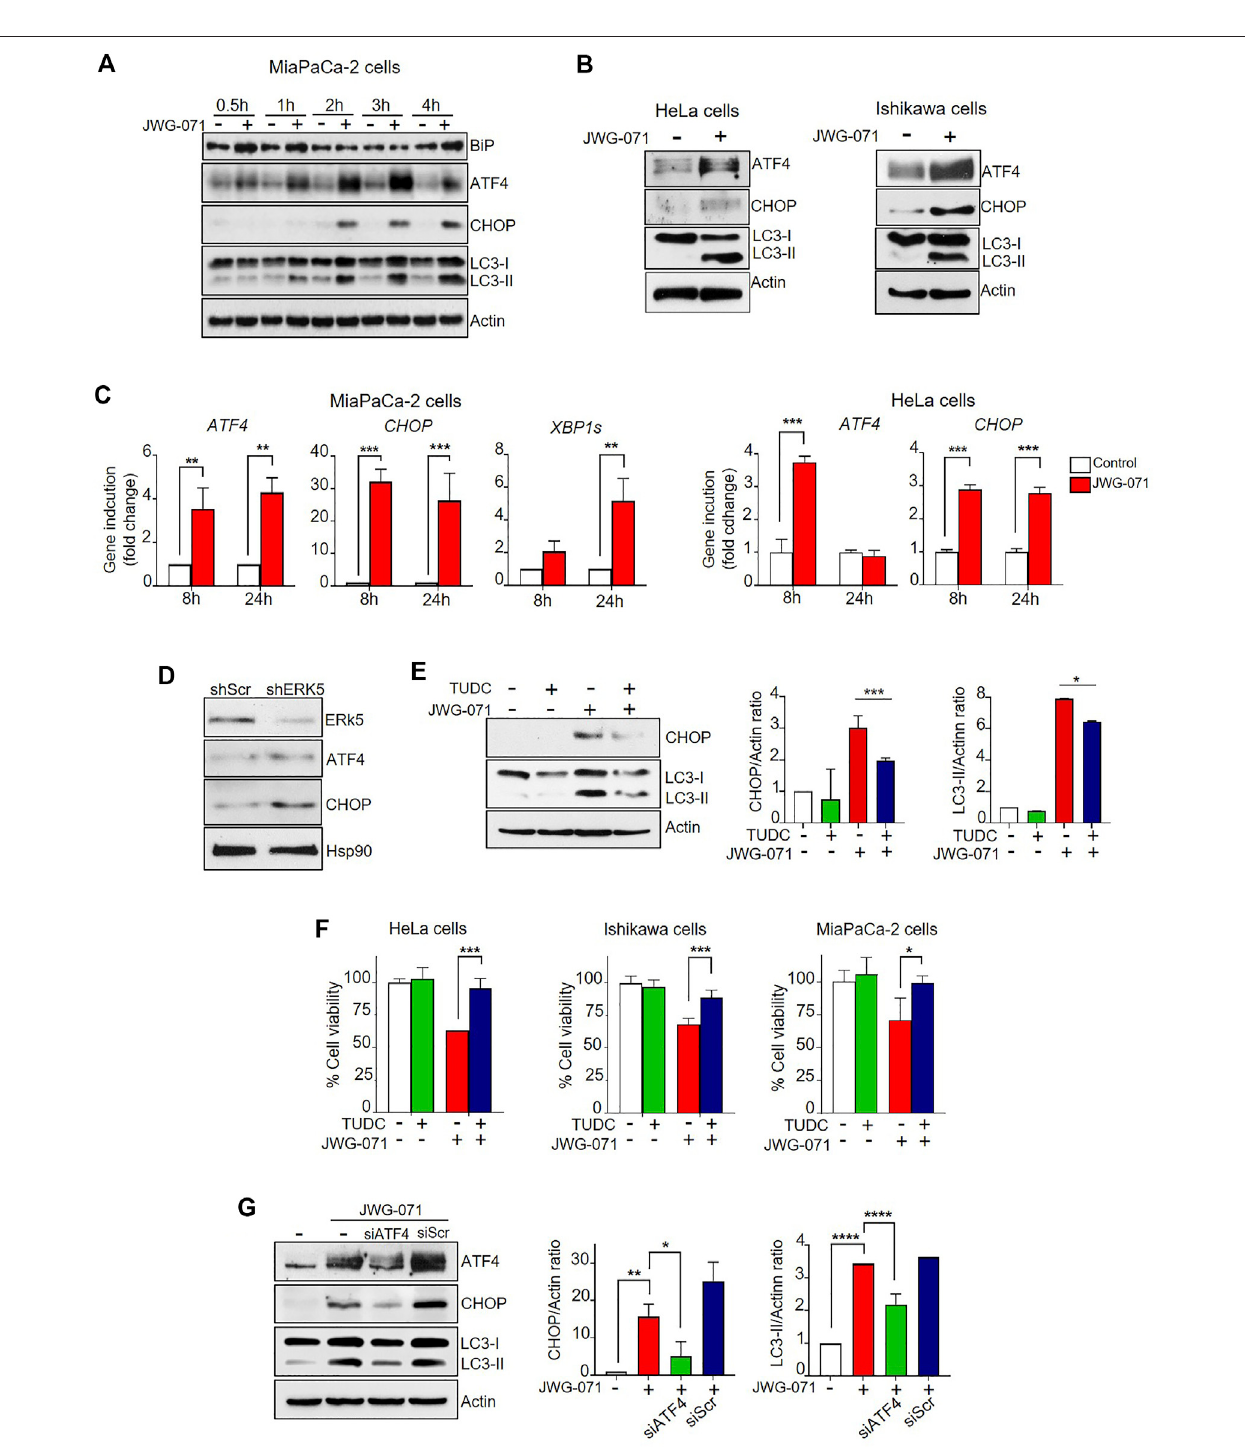
FIGURE 5 | ER stress and UPR mediates ERK5i-induced autophagy. (A) ERK5i induces ER stress and UPR, which precedes autophagy. MiaPaCa-2 cells were treated for the indicated times with either vehicle or 5 μ M JWG-071. The levels of the indicated proteins were monitored by immunoblot analysis. Actin was used as a loading control. (B) ERK5i induces UPR in HeLa and Ishikawa cells. Cells were treated with either vehicle or 5 μ M JWG-071 for 24 h, and levels of the indicated proteins weremonitored by immunoblot. (C) ERK5iinduces geneexpression ofUPR markers. MiaPaCa-2 and HeLa cellsweretreated with vehicle or 5 μ M JWG-071 for 8 or 24 h, and total RNA wasextractedand retrotranscribed to cDNA. ATF4 , CHOP , and spliced XBP1 ( XBP1s ) mRNA levels wereanalyzedby qRT-PCR and normalized by TBP ( ATF4 and CHOP )or HPRT1 mRNAlevels( XBP1s ).Valuesrepresentthemean ± SDoftwoseparateexperiments,eachperformedinduplicates.** p < 0.01*** p <